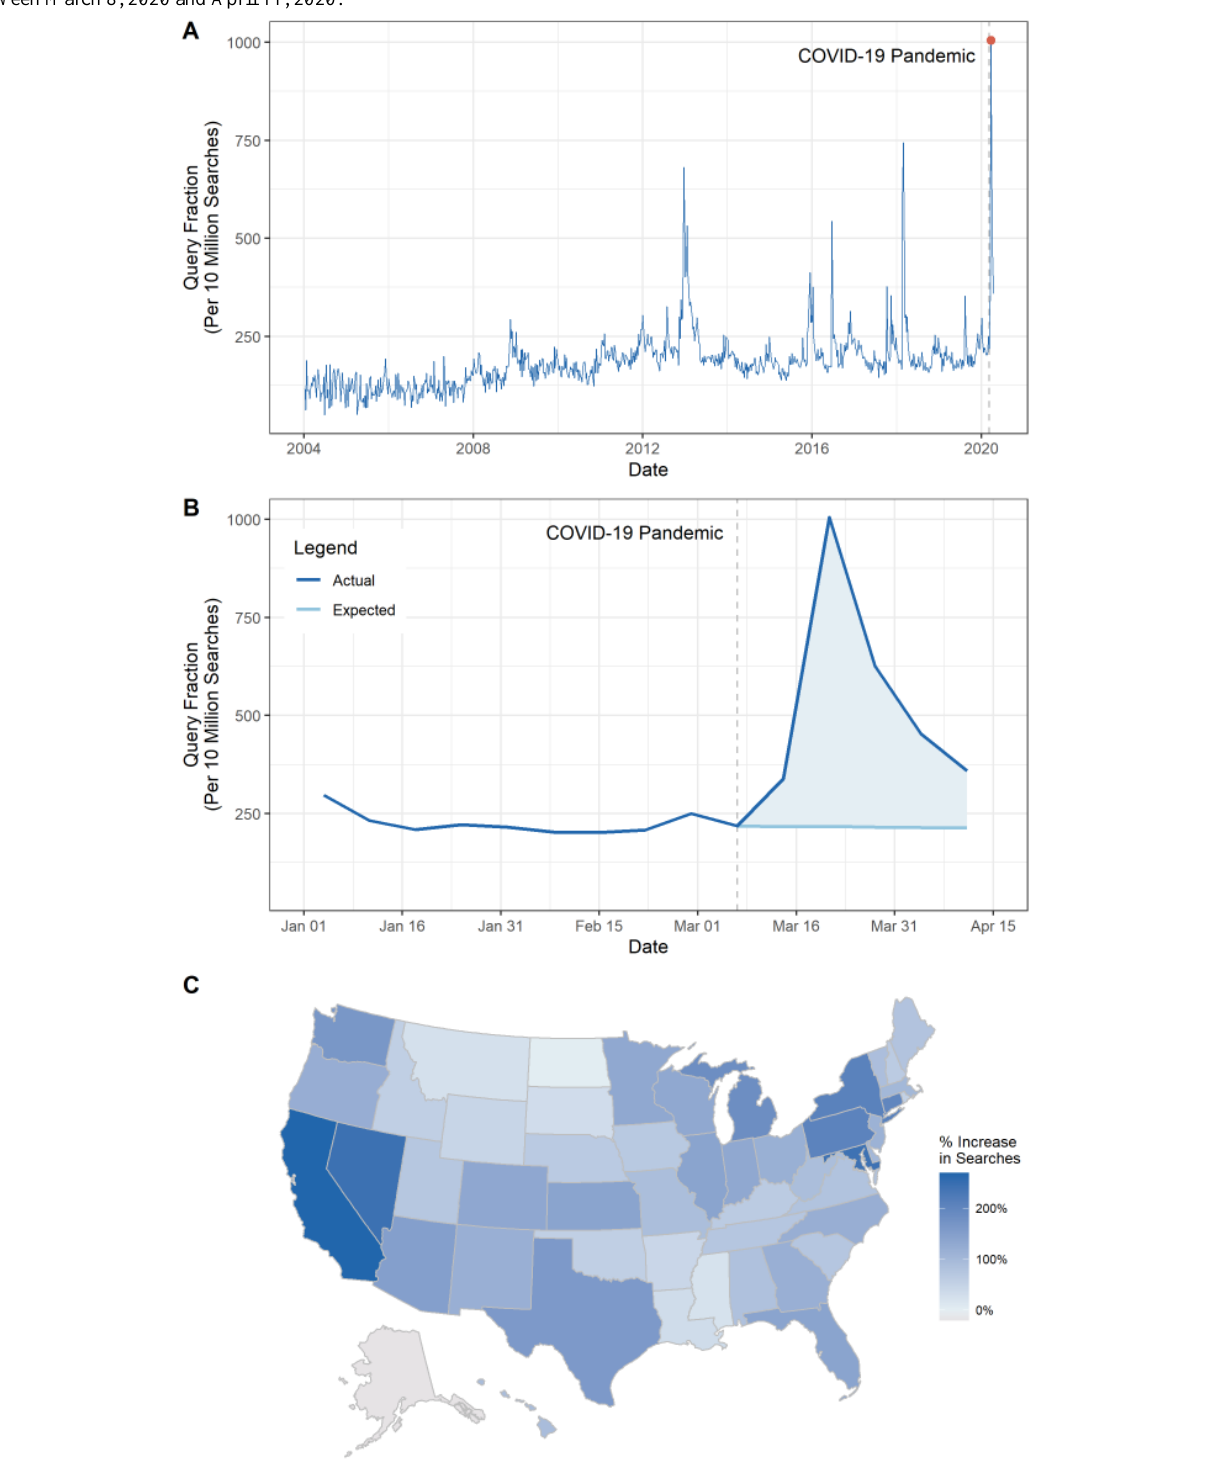
Figure 1. Google searches for gun preparation before and during the COVID-19 pandemic. A) The fraction of Google search queries that relate to gun preparation between January 1, 2004 and April 11, 2020. B) The fraction of Google search queries that relate to gun preparation between January 1, 2020 and April 11, 2020. C) The percentage change in the query fractions for a preperiod between January 1, 2020 and March 7, 2020 and a